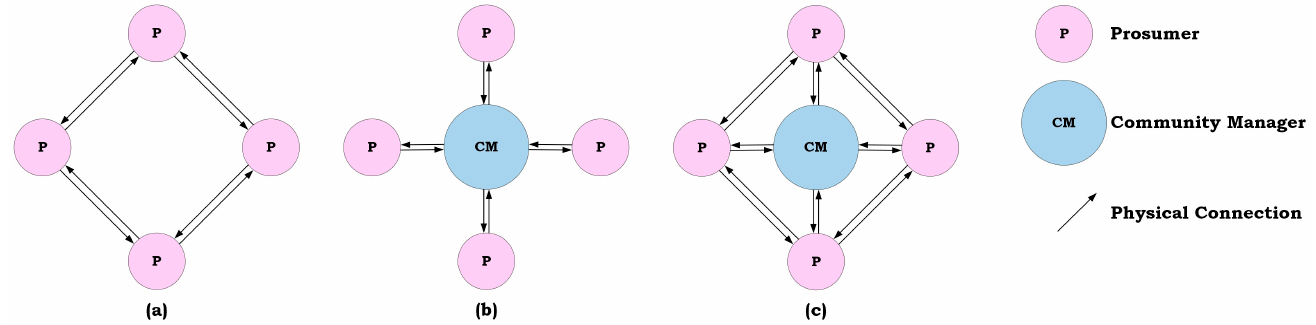
Figure 6. Energy trading mechanism for energy market: ( a ) full P2P market, ( b ) community-manager-based market, and ( c ) hybrid P2P market.